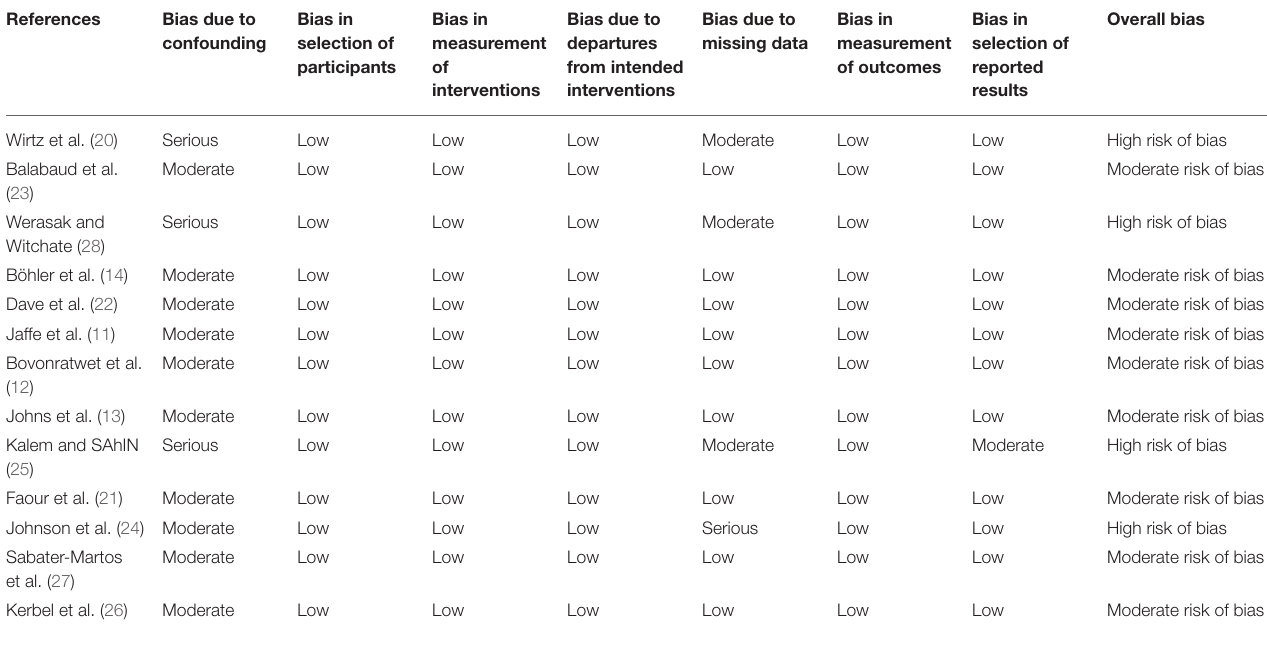
TABLE 3 | Risk-of-bias assessment of the retrospective cohort studies by